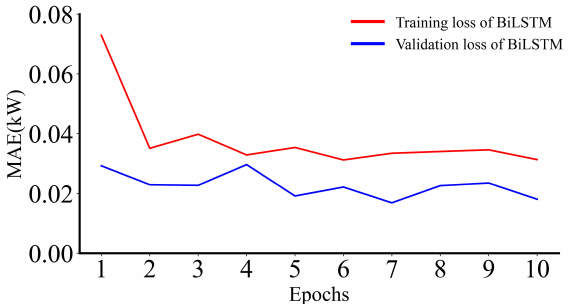
Figure 4. The training and validation losses of the BiLSTM model (single